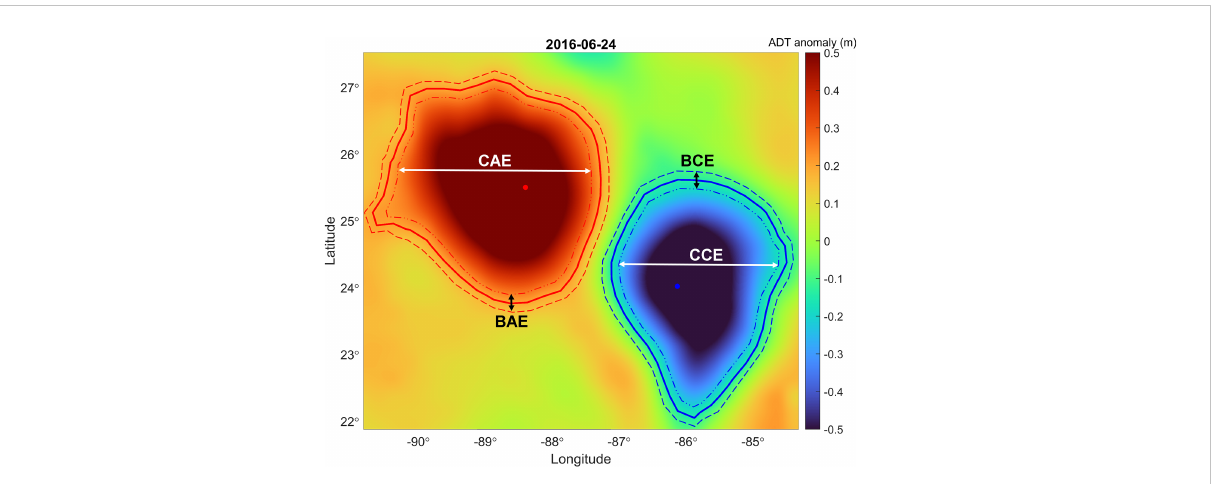
FIGURE 2 Absolute dynamic topography anomaly map depicting cyclonic and anticyclonic mesoscale structures observed on June 24, 2016. The blue/red line and dot represents the cyclone/anticyclone contour and center; data extracted from the altimetric Mesoscale Eddy Trajectories Atlas at AVISO+. The areas delimited by the dotted lines represent the border and center classi fi cation zone for the sampling stations that were in mesoscale structures.